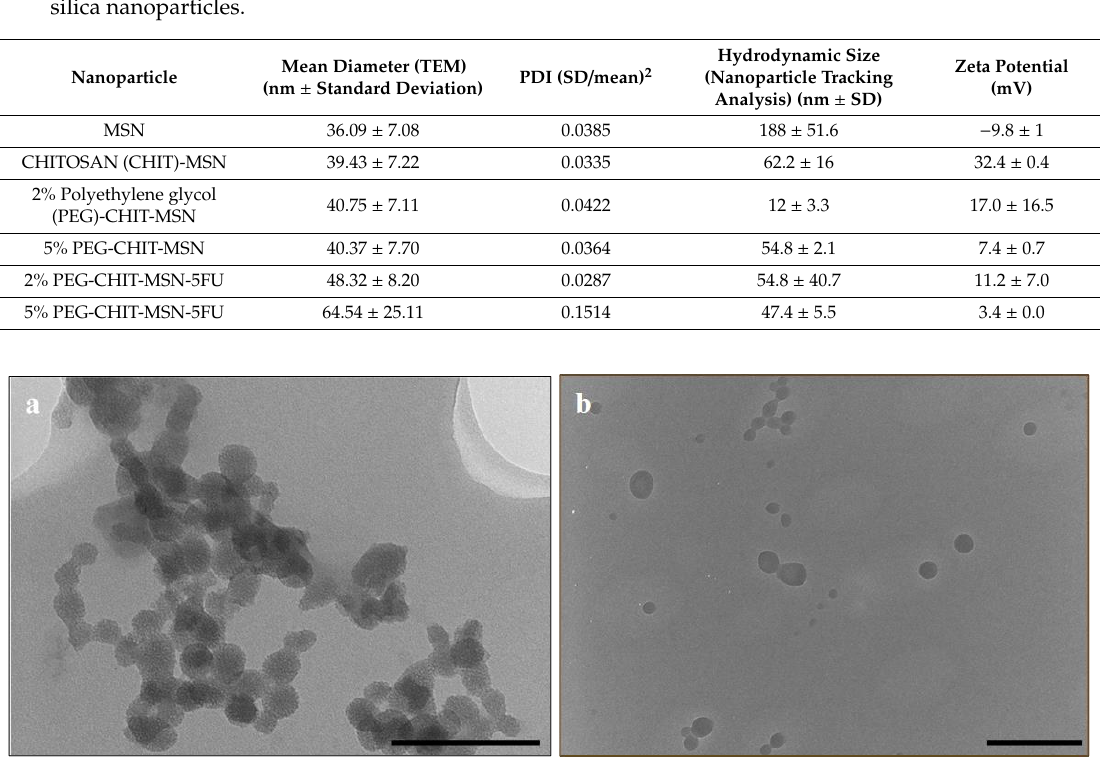
Figure 3. Nitrogen adsorption-desorption isotherm for synthesized MSN.